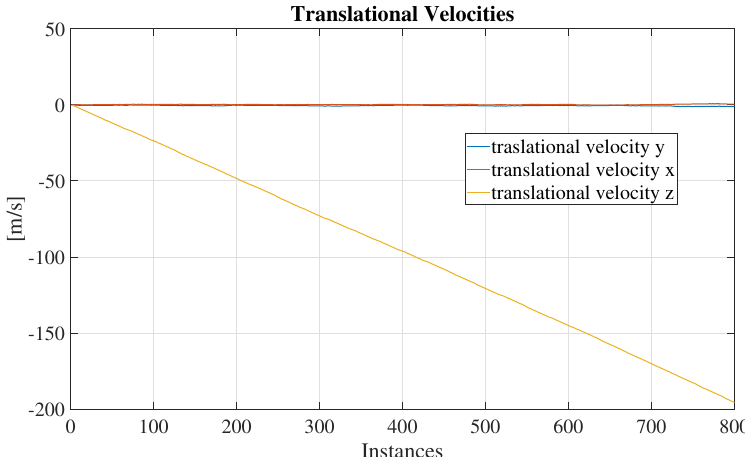
Figure 8. Translational velocities x , y , z